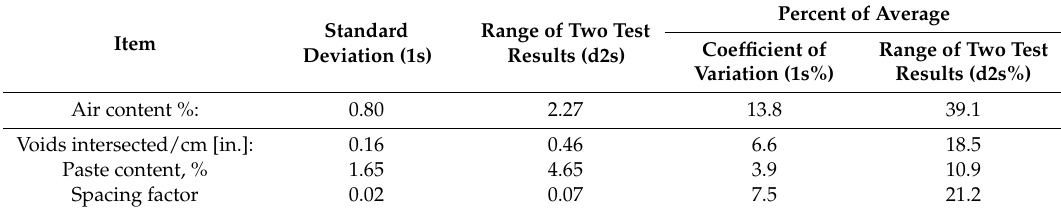
Table 1. Average precision of the assessment made by one operators on a set of 54 specimens (27 dosages with two slabs per dosage). The complete results can be found in the Appendix A at the end of the study.